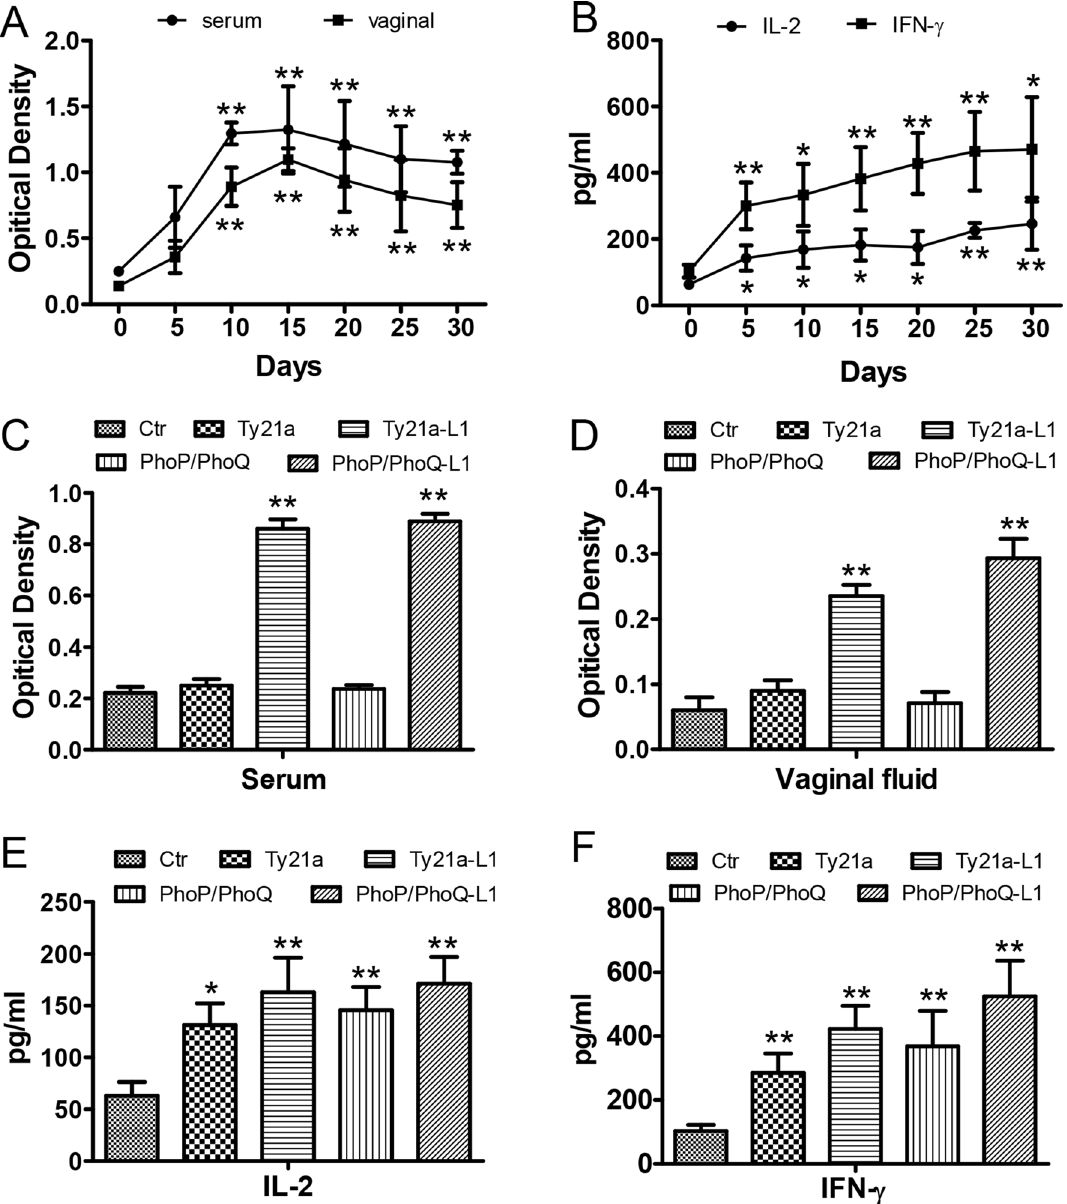
Figure 2. After immune with attenuated Salmonella carrying pcDNA3.1-HPV16-L1, antibodies were produced and cytokines were increased in mice. ( A ) ELISA detection of anti-HPV16-L1 antibody after vaccinated 1 time. *P < 0.05, **P < 0.01, vs the 0d group. ( B ) ELISA detection of IL-2 and IFN-γ after vaccinated 3 times. *P < 0.05, **P < 0.01, vs the 0d group. ( C , D ) ELISA detection of anti-HPV16-L1 antibody after vaccinated 3 times. **P < 0.01, vs the control group. ( E , F ) ELISA detection of IL-2 and IFN-γ after vaccinated 3 times. *P < 0.05, **P < 0.01, vs the control